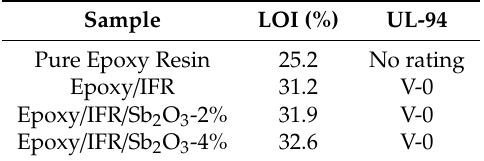
Table 5. Limited Oxygen Index (LOI) and UL-94V results of the coatings. Sample